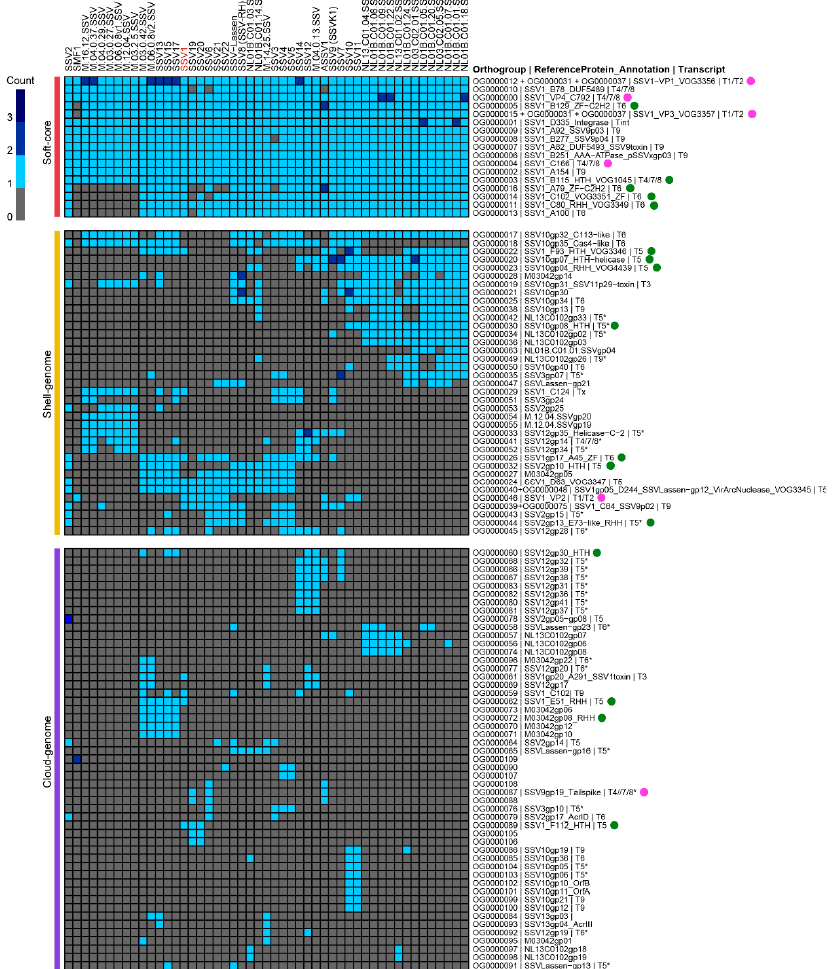
Figure 2. The pangenome of the Fuselloviridae . Presence and absence heatmap of clusters of homologous proteins in 49 fuselloviruses. Genes present in > 80% of the strains were labeled as part of the soft-core genome (red line), genes present in >20% of the genomes are part of the shell-genome (yellow line), and the rest are considered the cloud-genome (purple line). Singletons are not shown. Pink circles indicate virion proteins, and green circles indicate putative transcriptional regulators. Asterisks (*) indicate that location of the reference gene within the corresponding genome is puta- tive.